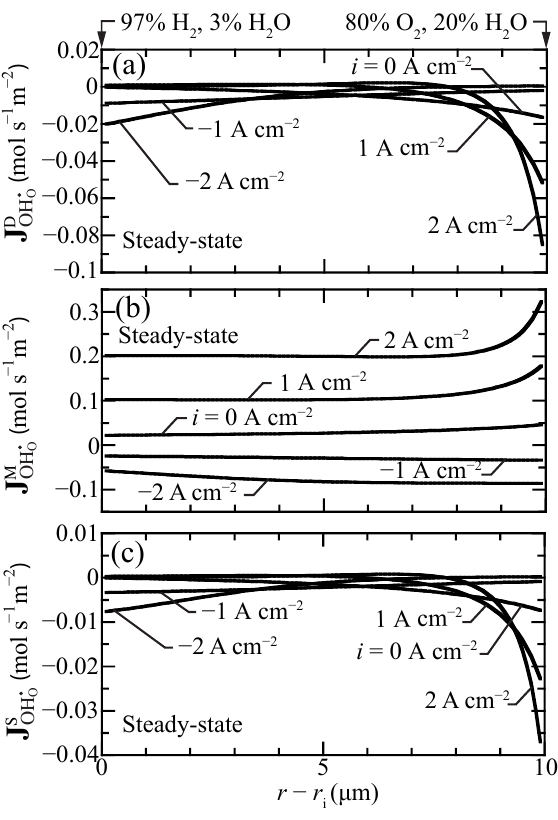
Figure 5. Steady-state proton-flux contributions for selected current densities ( i = − 2, − 1,0,1,2 A cm − 2 ) at 600 ◦ C. ( a ) diffusion flux, ( b ) migration flux, and ( c ) stress-induced flux.